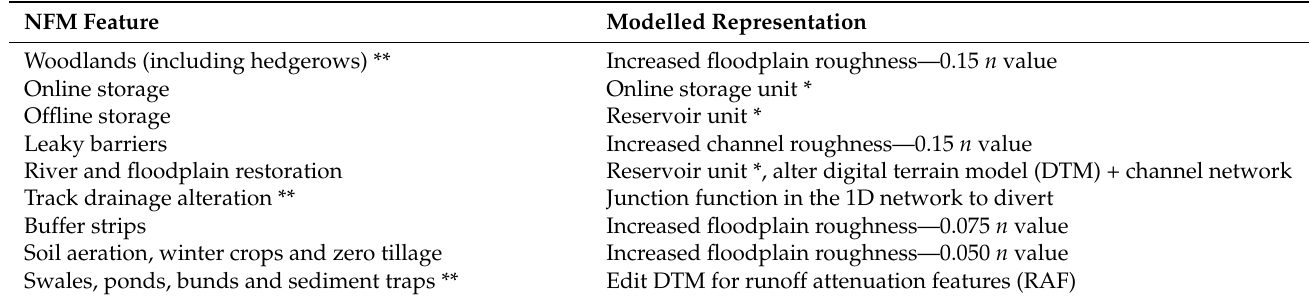
Table 2. Modeled representation of co-designed NFM